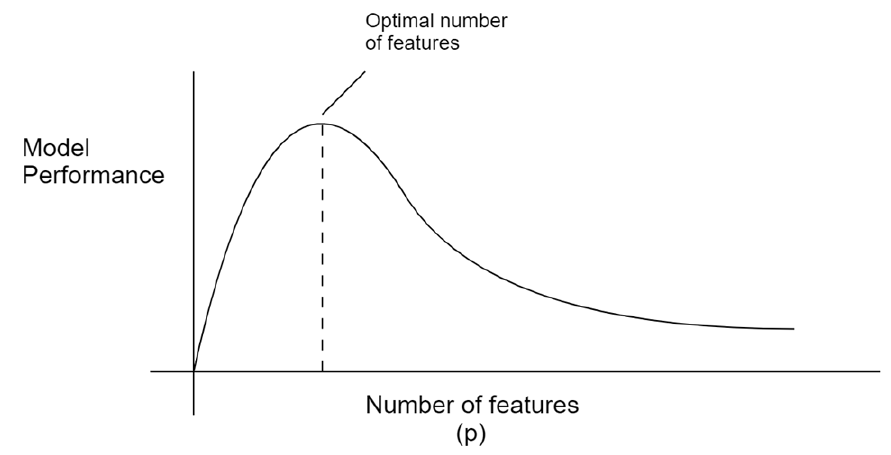
Figure 1. Effect of number of features on performance of